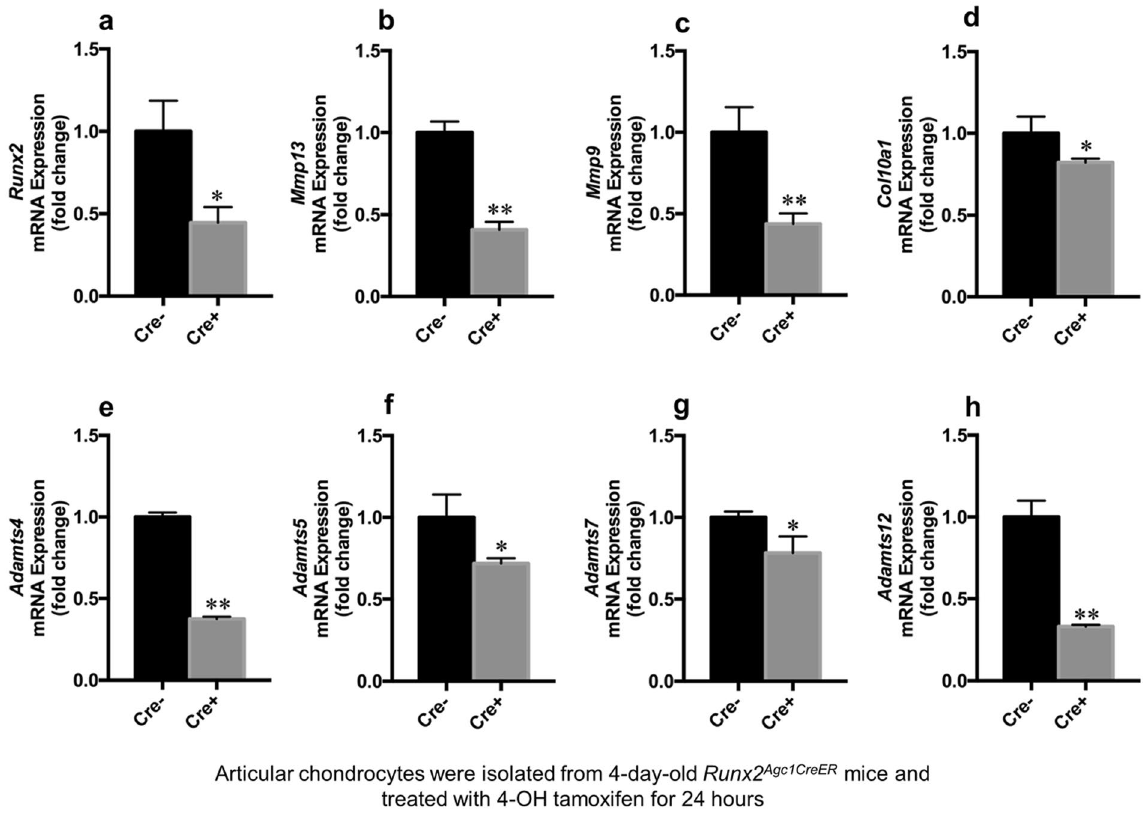
Figure 6. Loss of Runx2 in chondrocytes isolated from early postnatal mice causes decreased expression of genes encoding to matrix degradation enzymes. ( a – h ) Primary articular chondrocytes were isolated from 4-day-old Runx2 Agc1CreER mice (Cre + ) and Cre-negative control mice (Cre − ) and treated with 4-hydroxy tamoxifen (1 μ M) for 24 hours, followed by real-time PCR assay. Expression of Mmp9 , Mmp13 , Adamts4 , Adamts5 , Adamts7 and Adamts12 was significantly reduced in Runx2 deficient chondrocytes ( * P < 0.05 and ** P < 0.01, Unpaired Student’s t -test; n = 3 mice per